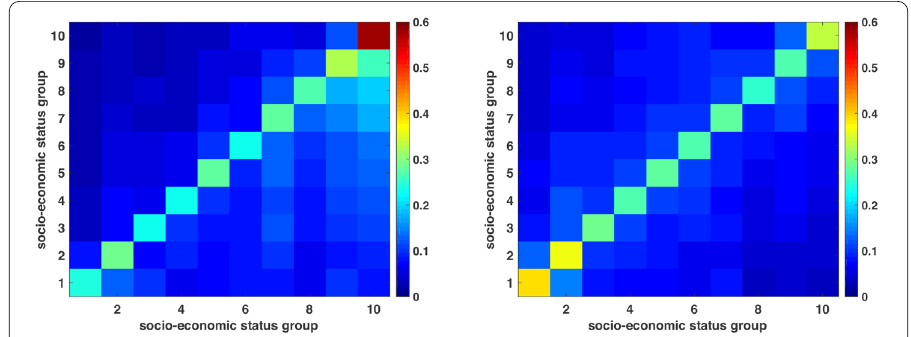
Figure 11 Mixing matrices for (Left) the purchase network and (Right) the Twitter mention network, for ten socio-economic status groups in the European metropolitan area. Socio-economic status groups are ordered from the lowest wealth (1) to the highest wealth